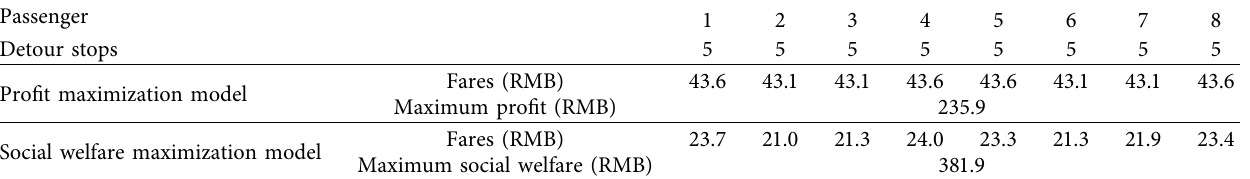
Table 3: Results of case